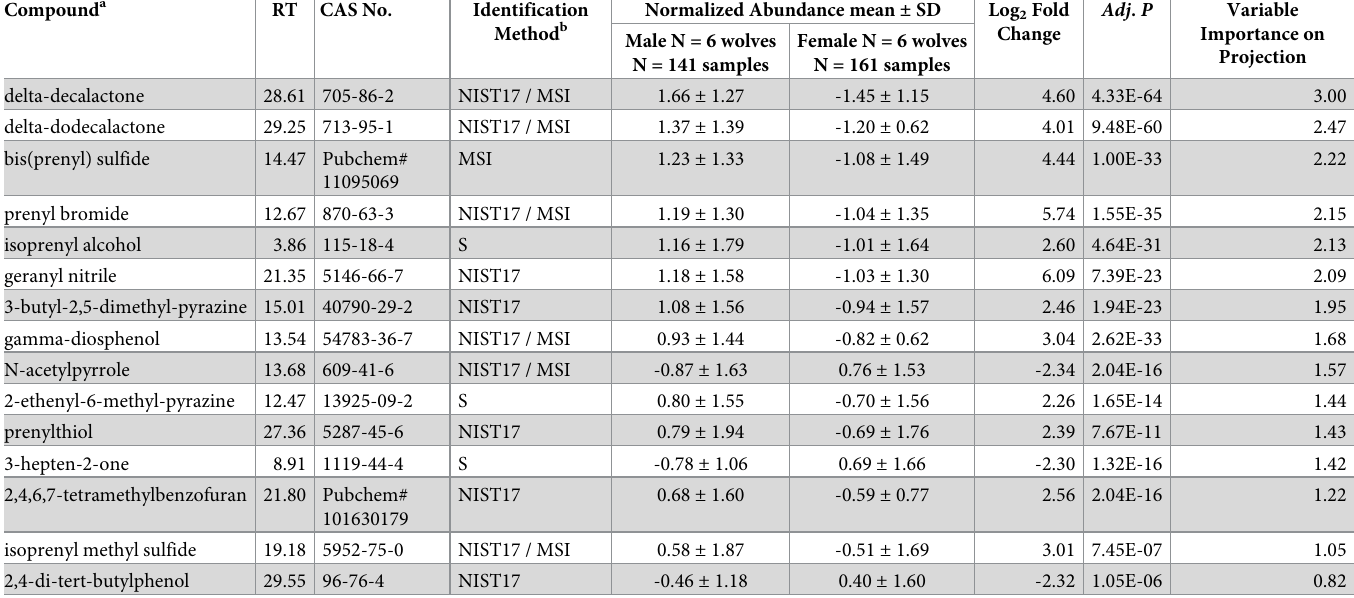
Table 3. VOCs that differed significantly between male and female maned wolf urine samples.